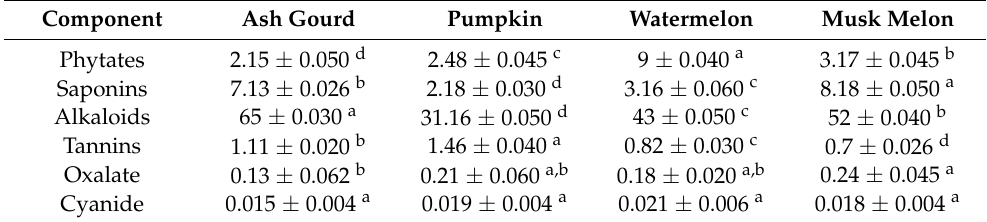
Table 4. Antinutritional compounds of seeds (mg/100